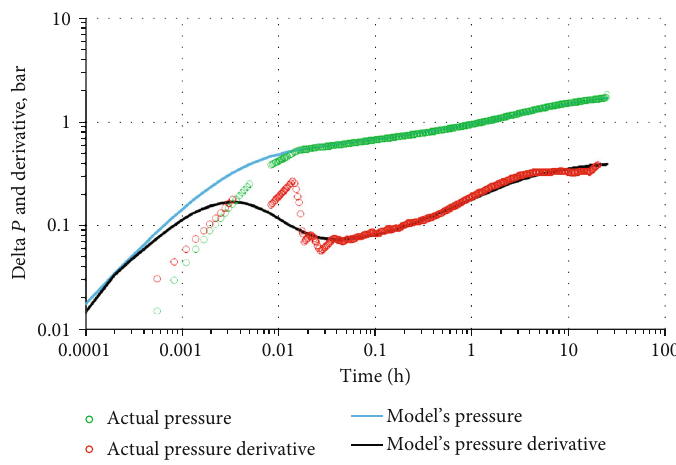
Figure 5: Interpretation chart of P-4 pressure